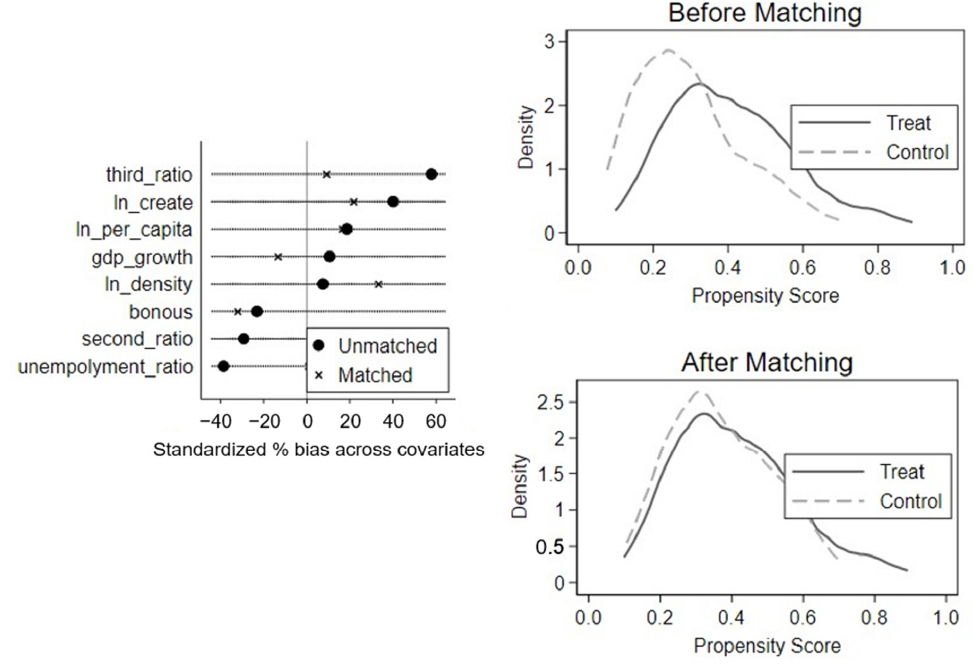
Figure 2. Propensity score matching (PSM).